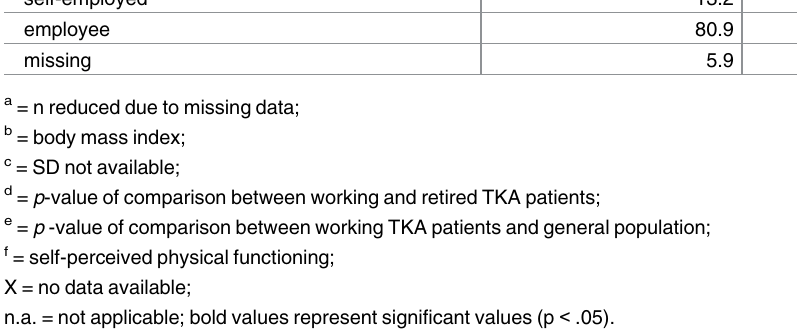
functioning, 95 patients (63.3%) scored worse on vitality and 148 patients (98.0%) perceived more pain. For self-perceived physical functioning, 148 patients (96.1%) scored worse on phys- ical functioning, 144 patients (95.4%) scored worse on the pain subscale and 141 (95.3%) patients scored worse on the stiffness subscale. For psychological factors, 48 (31.8%) patients scored worse on mental health, 49 (32.7%) patients scored worse on emotional role function- ing and 93 (61.2%) patients had more depressive symptoms. Lastly, 95 (63.3%) patients per- ceived worse social functioning than the general